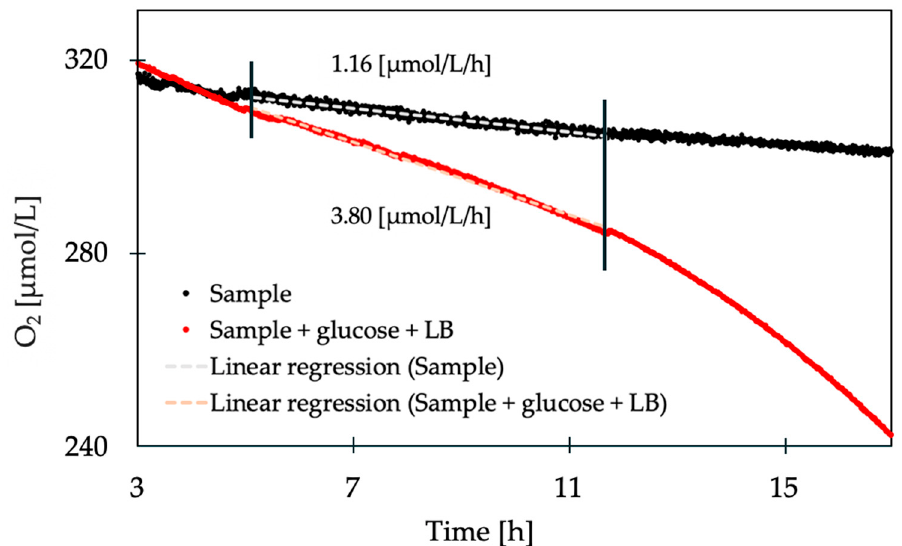
Figure 4. Comparison of the decrease in O 2 concentration over time of a pure sample compared to a sample with added glucose and LB medium. The respective respiration rates were determined via linear regression and are displayed within the graph.